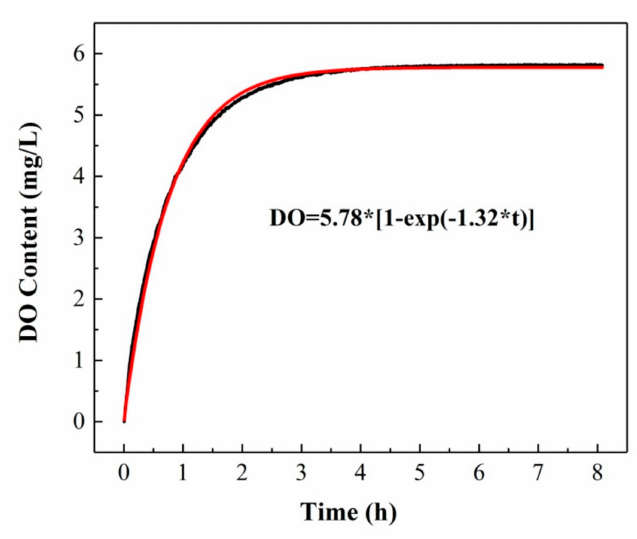
Figure 9. The variation of DO content; kinetic